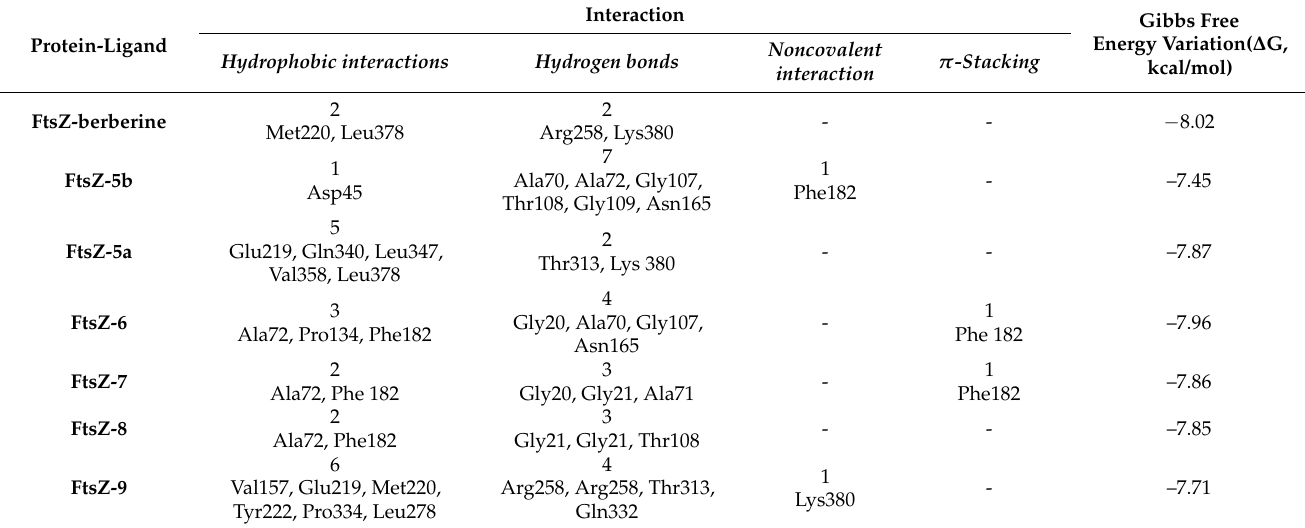
Table 2. Interactions between FtsZ protein and berberine or its analogues.